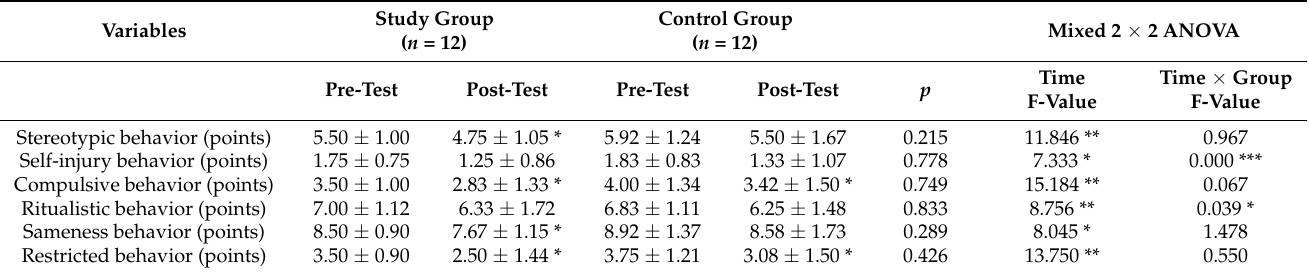
Table 2. The results of restricted and repetitive behaviors within and between-group comparison.